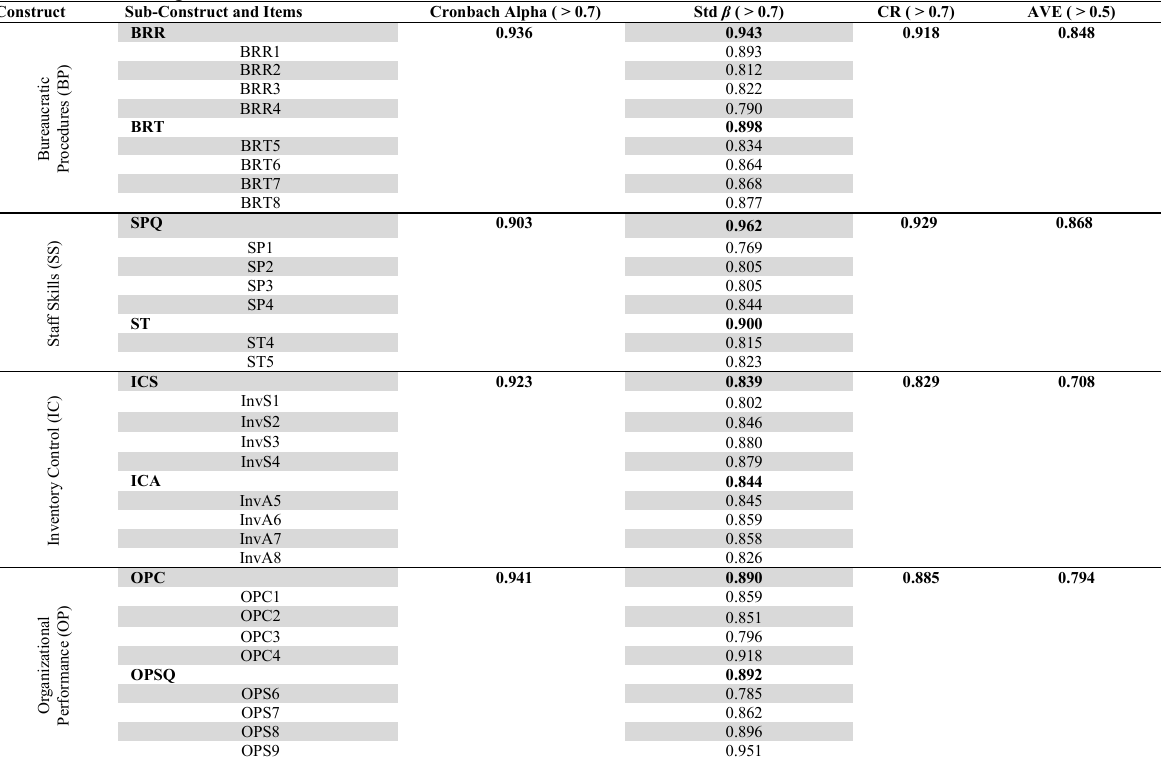
Standardized Loading, Cronbach’s a, CR, and AVE for Full Model Construct Sub-Construct and